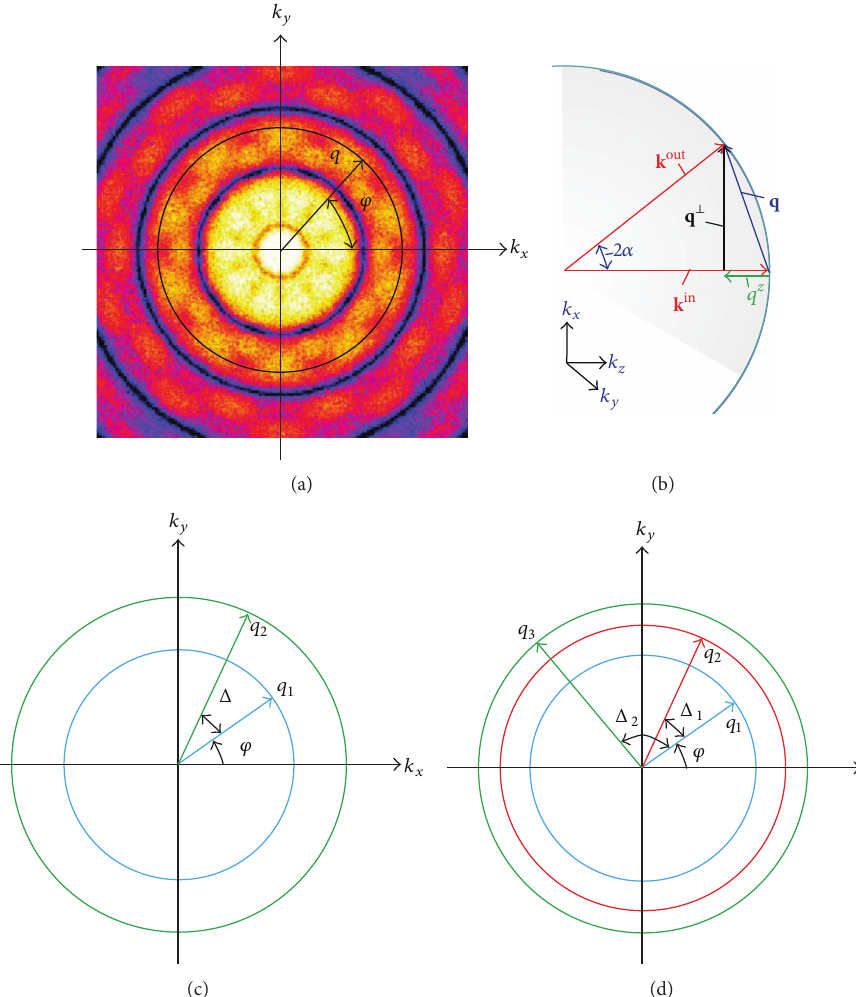
Figure 3: Scattering geometry in reciprocal space. (a) Scattered intensity 𝐼( q ) defined in the detector plane in the polar coordinate system, q = (𝑞, 𝜑) . (b) Ewald sphere construction. Here k in is the wavevector of the incident beam directed along the 𝑧 axis, k out is the wavevector of the scattered wave with the scattering angle 2𝛼 . The scattering vector q = ( q ⊥ , 𝑞 𝑧 ) is decomposed into two components that are perpendicular q ⊥ and parallel 𝑞 𝑧 to the direction of the incident beam. Definition of the momentum transfer vectors in the derivation of the two-point , 𝑞 ,Δ) (c), and three-point CCFs 𝐶(𝑞 𝐶(𝑞 1 2